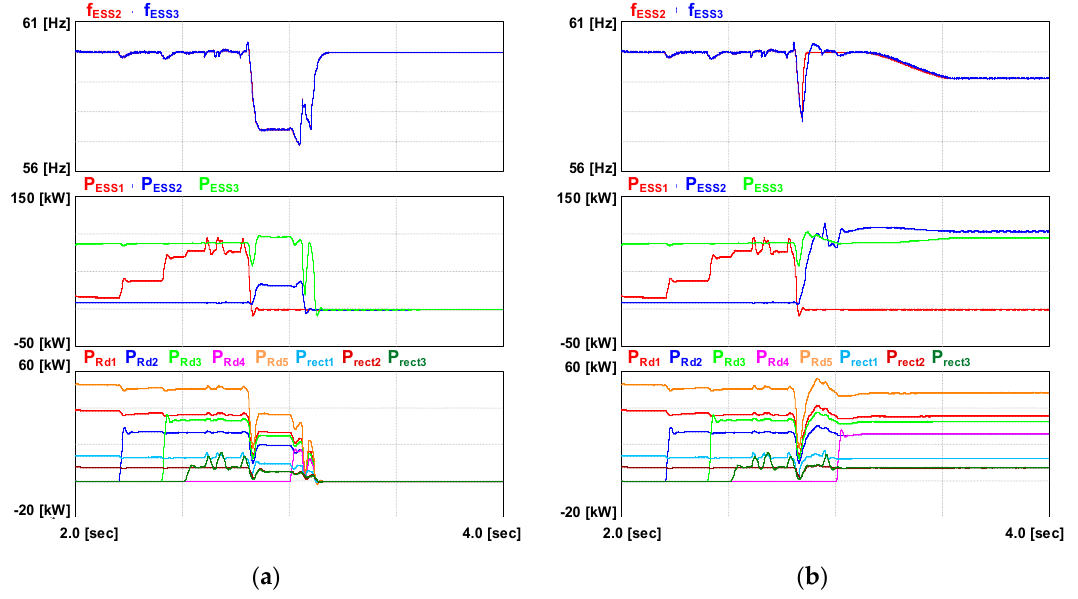
Figure 12. Simulation results (case 5 and case 6)—( a ) case 5; ( b ) case 6.